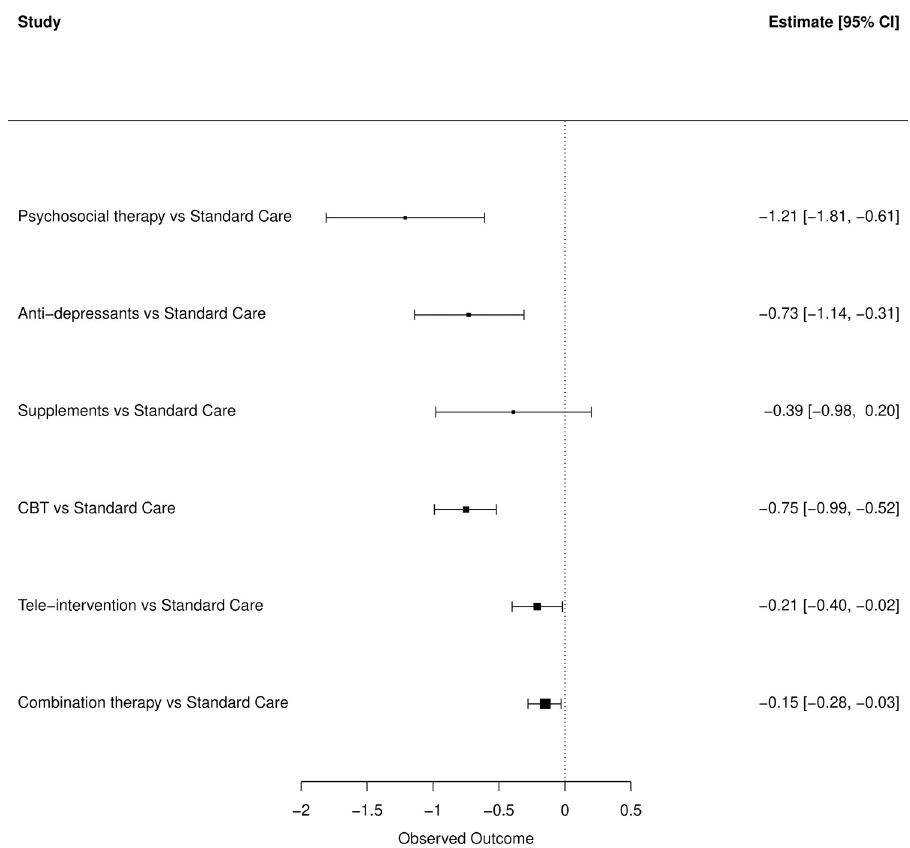
Fig 3. Forest plot of bivariate analysis for depression scores.